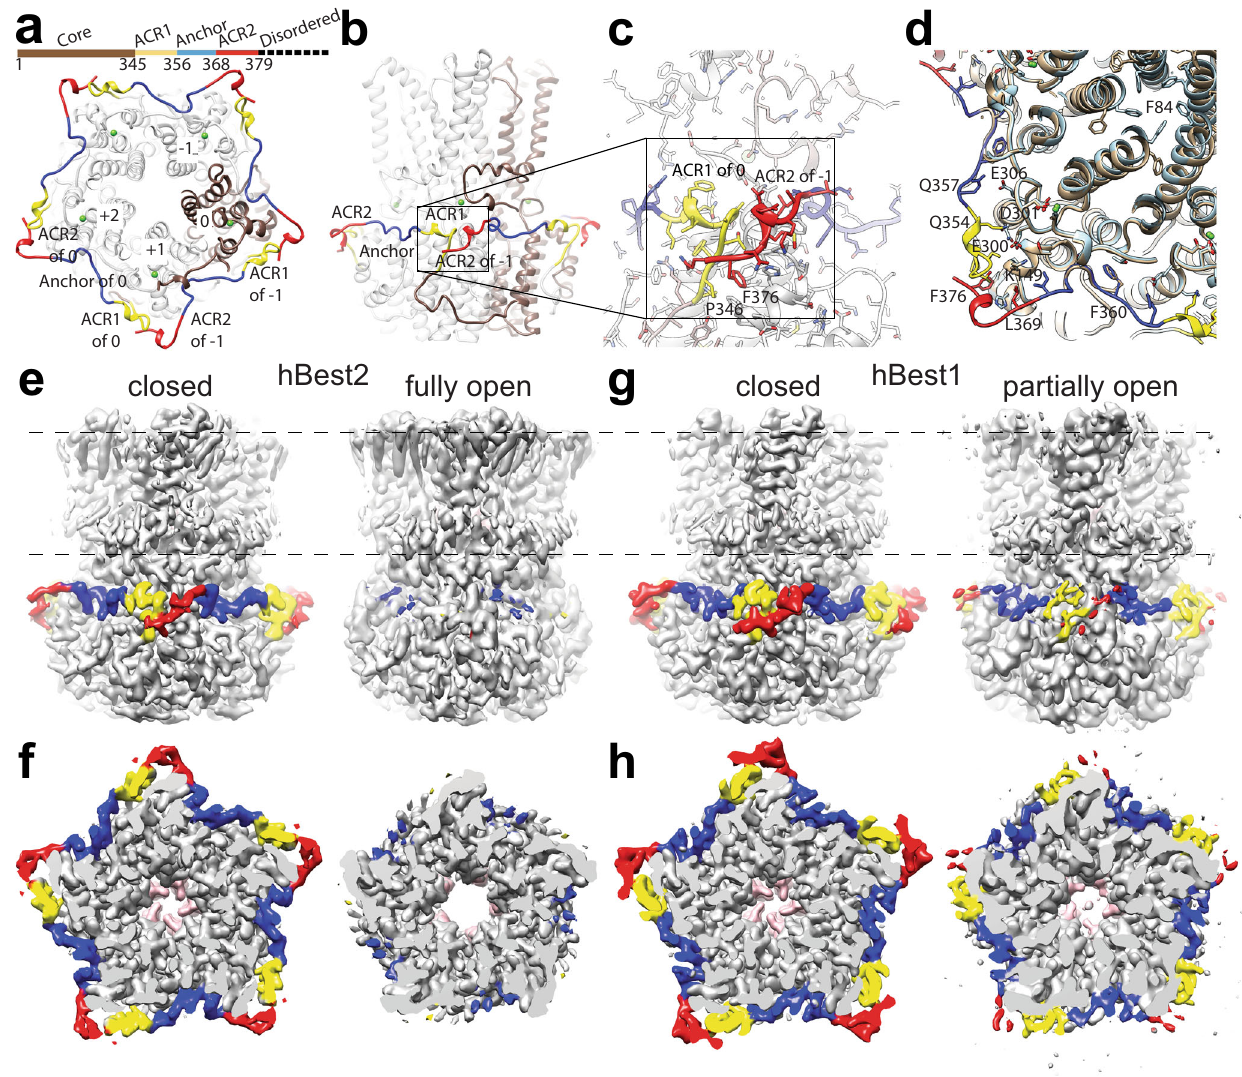
Fig. 3 The AS constricts the channel concentrically. a , b Color-coded schematic showing the speci fi c segments of the AS and the channel core of protomer 0 colored copper. Protomers are numbered. Green dots, Ca 2 + ions. c Closeup of ACR2 of protomer − 1 interacting with ACR1 of protomer 0 proximal to the Ca 2 + -clasp of protomer + 1. d Conformational change of F84 illustrated by superimposition of the closed and open states of Ca 2 + -bound hBest2. Residues of the AS contributing to neck closure by constriction of the Ca 2 + clasp are shown. e – h Coordinated ordering and disordering of the AS between the Ca 2 + - bound closed and open states of hBest2 from side e and top f views and hBest1 from side g and top h views. Residues of the neck are colored pink.